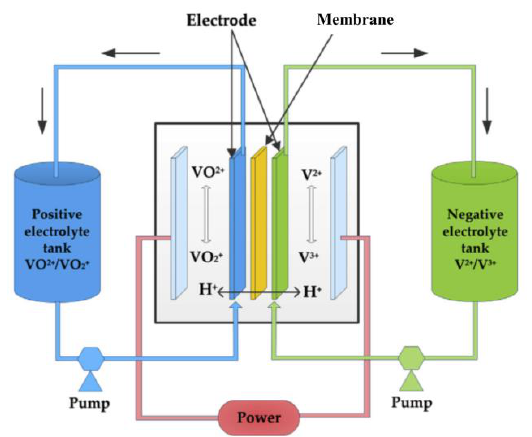
Figure 16. The schematic illustration of a first-generation vanadium-redox flow battery (RFB) (reproduced from reference [144] with permission. Copyright 2018, Elsevier).